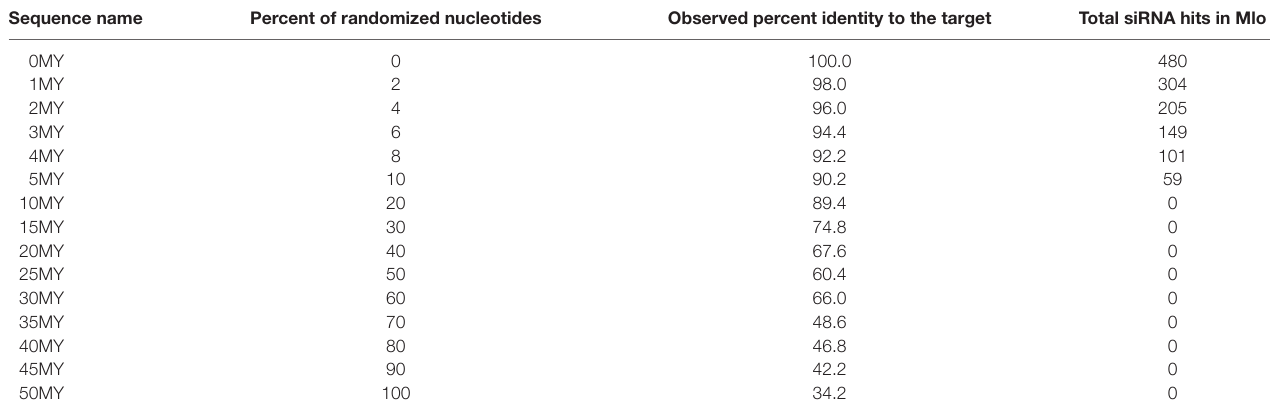
TABLE 1 | Properties of the synthetic DNA sequences based on the “molecular clock” model for RNAi trigger lengths of 500 bp. Sequence